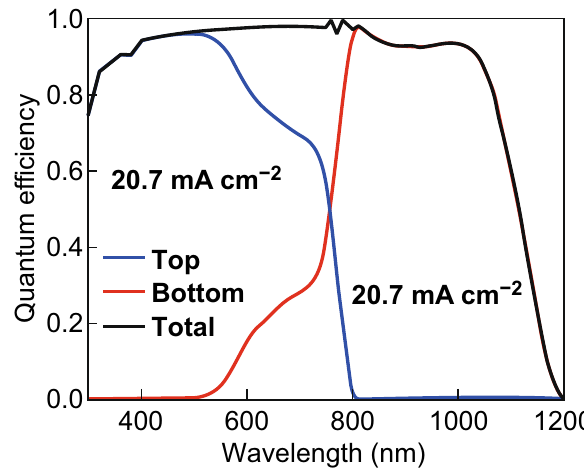
Fig. 15 The calculated quantum efficiency of the top, bottom, and total perovskite/silicon solar cell under matched short-circuit current